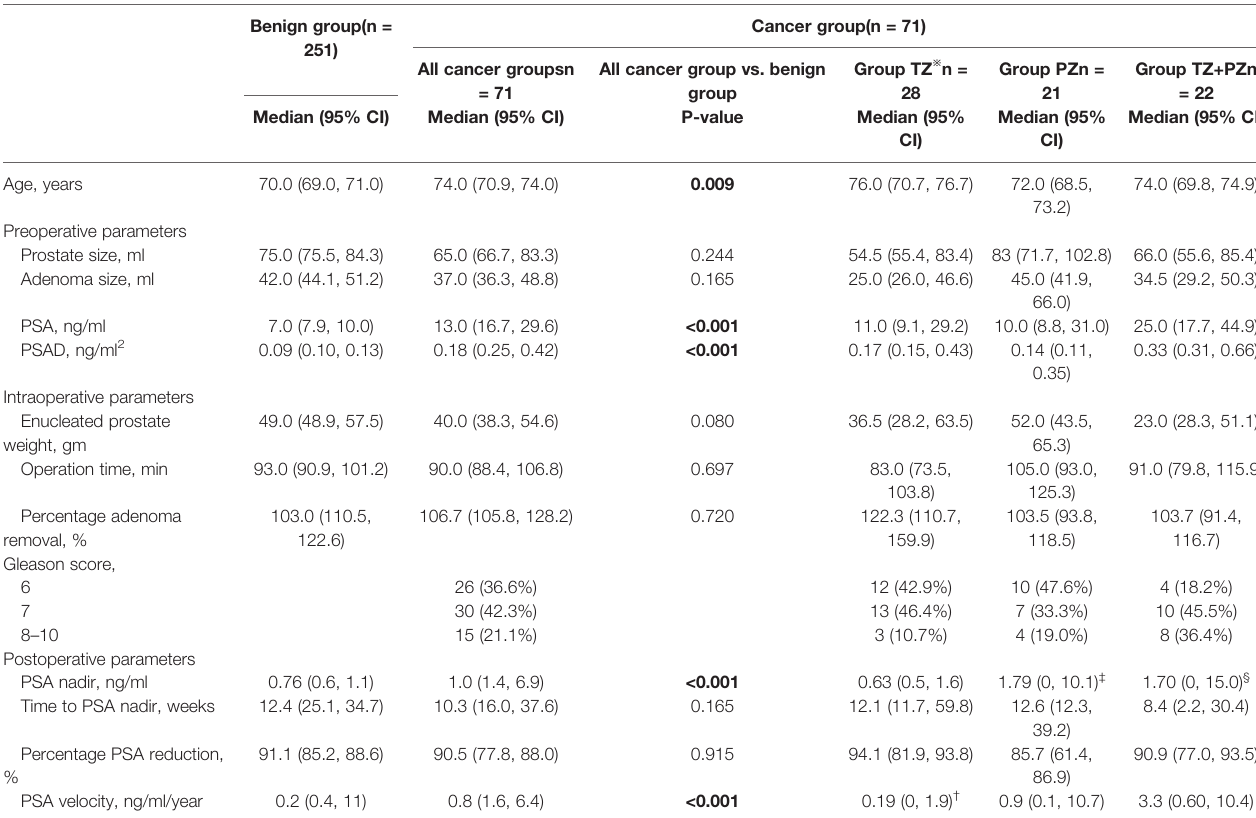
TABLE 1 | Characteristics and perioperative parameters of patients who underwent